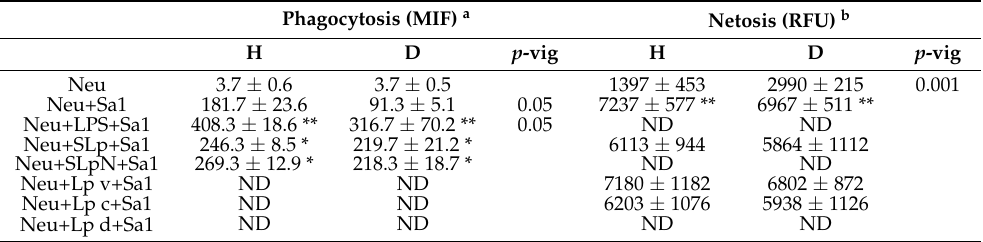
Table 3. Biological activity of blood neutrophils ex vivo. Phagocytosis mean fluorescence intensity (MIF).